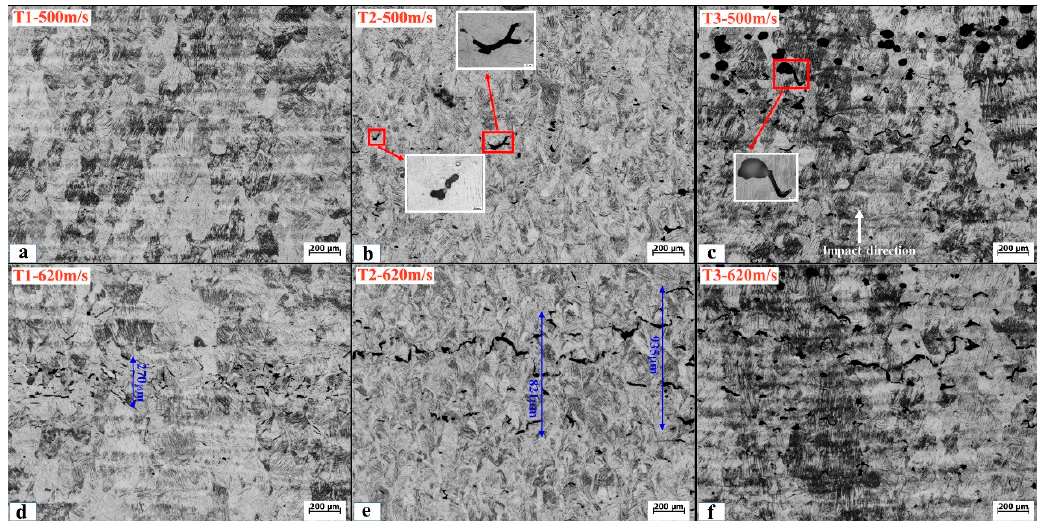
Figure 7. Optical metallography of three SLM TC4 samples shock-recovered at the impact velocity of (a)(b)(c) 500 m/s and (d)(e)(f) 620 m/s.